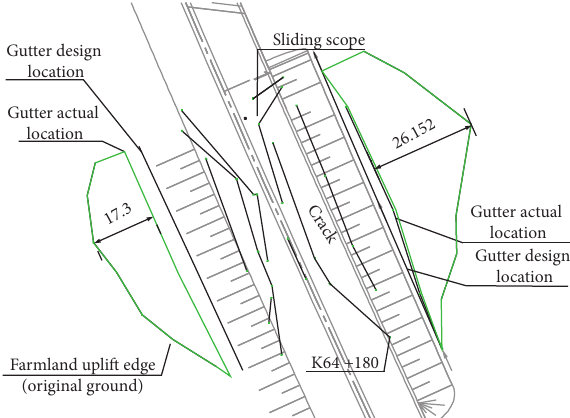
Figure 3: Schematic plan of the embankment in the sliding